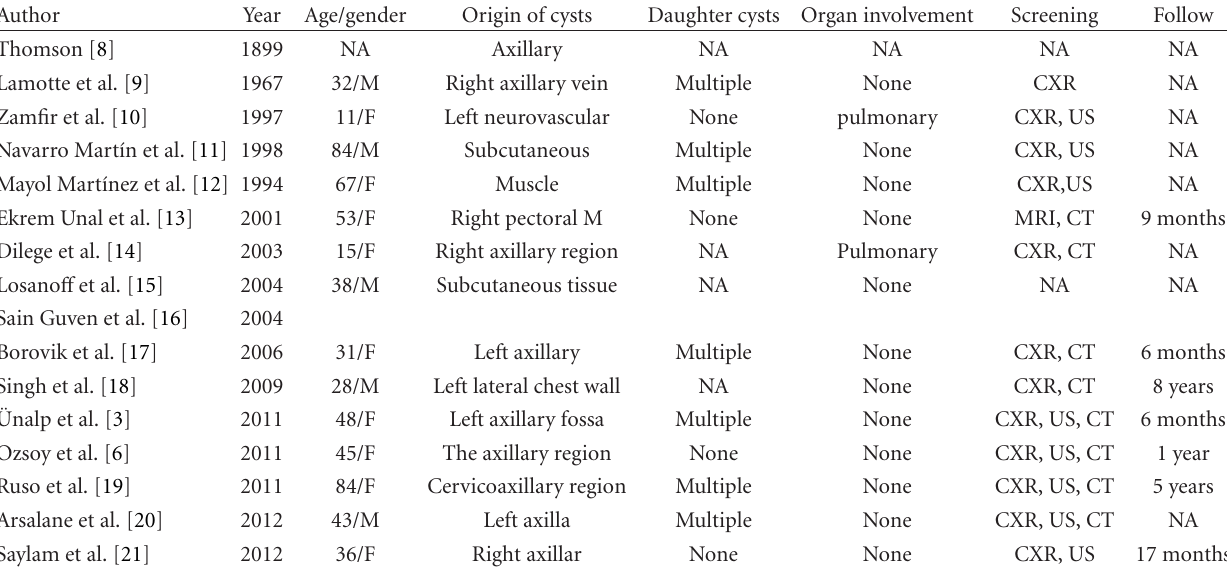
Table 1: Reported cases of hydatid cysts of the